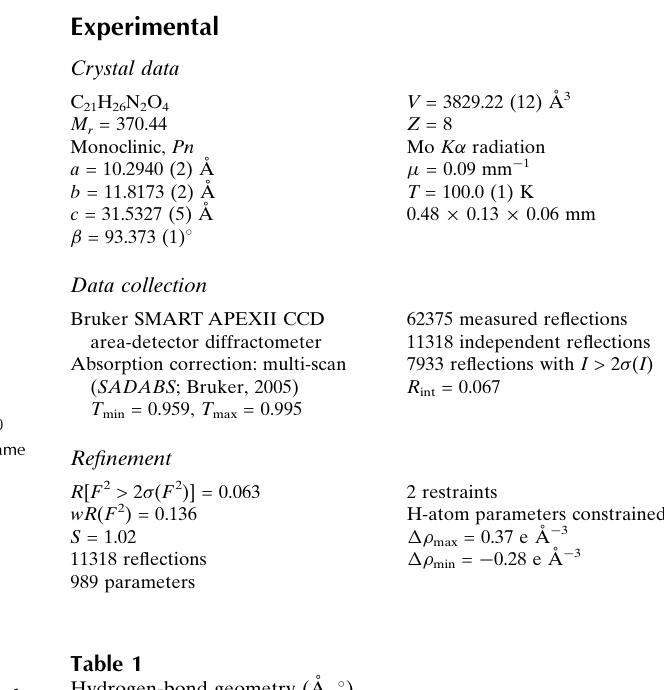
Hydrogen-bond geometry (A˚ , (cid:2)